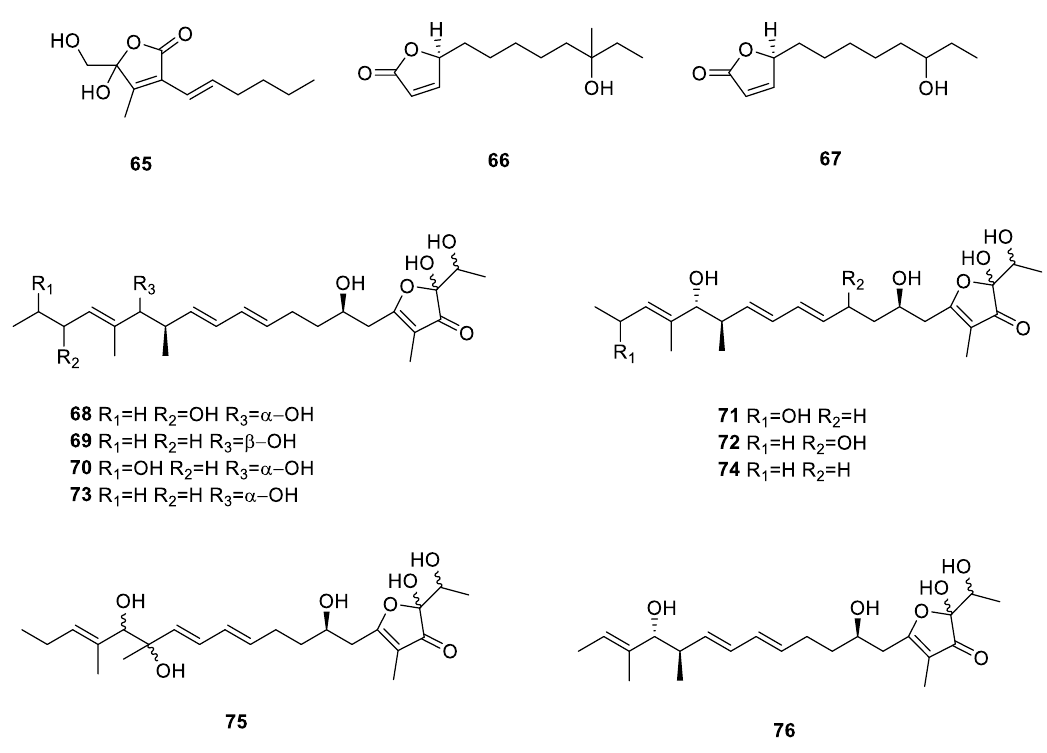
Figure 9. Chemical structures of compounds 65 − 76 from lichen-associated actinomycetota.